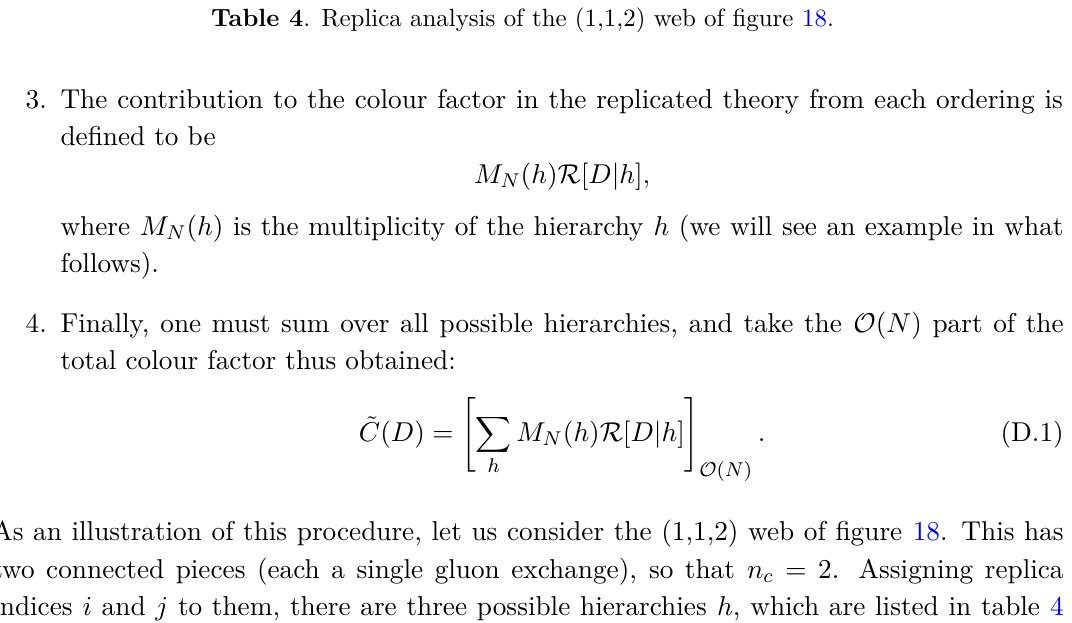
Table 4 . Replica analysis of the (1,1,2) web of figure